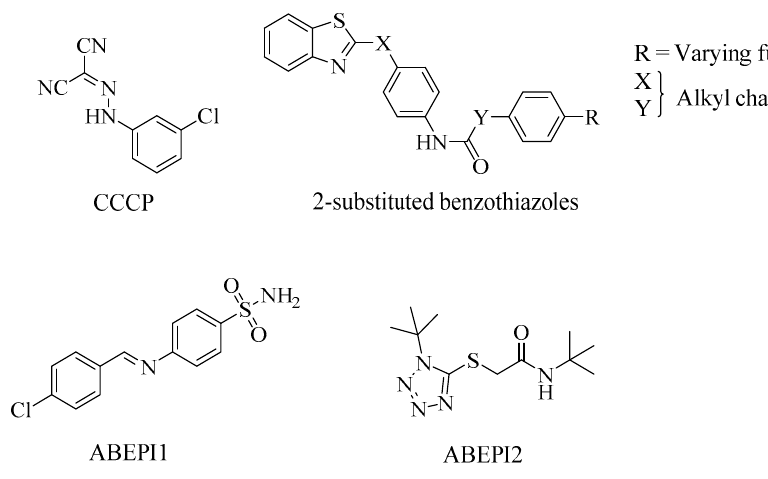
Figure 6. Investigational EPIs tested against A. baumannii.